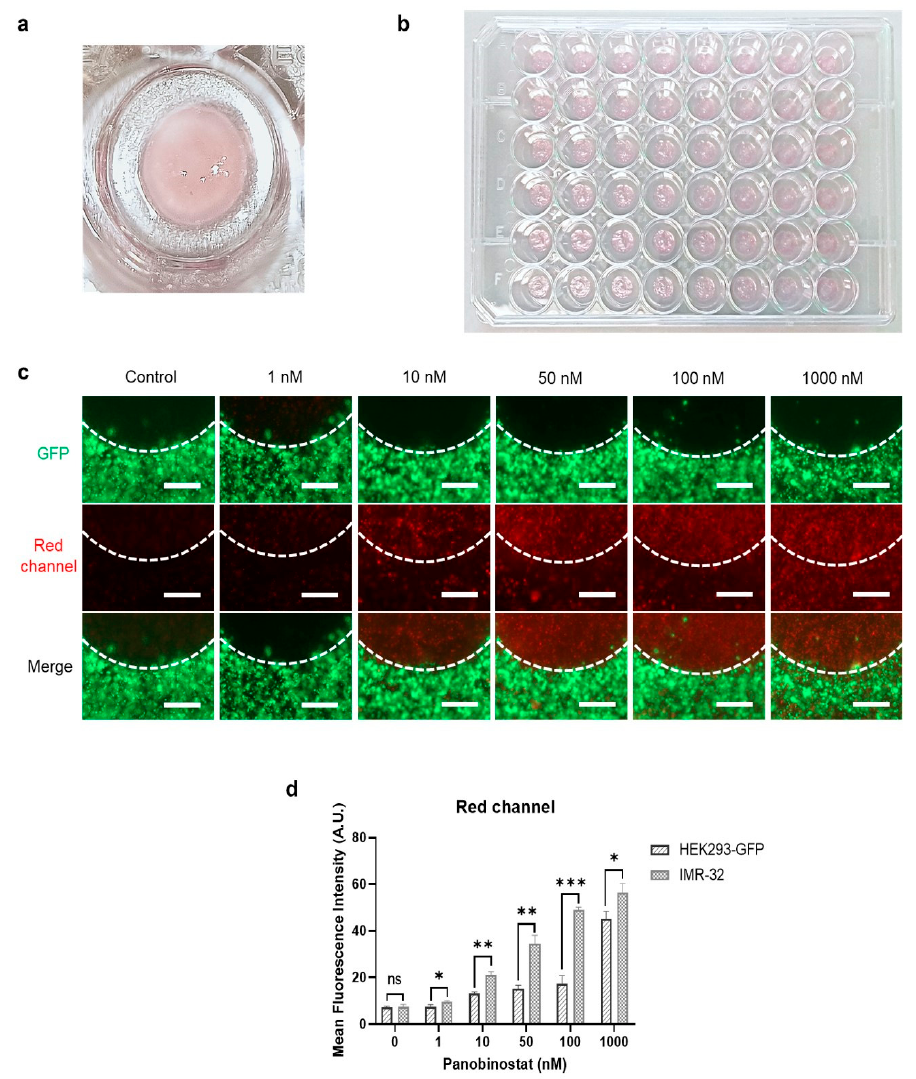
Figure 6. Cancer model and cytotoxicity assays following treatment with panobinostat. ( a ) The bioprinted cancer model consisted of a core of neuroblastoma IMR-32 cells (diameter of 3 mm, height of the construct 0.4 mm) surrounded by an environment of kidney cells (HEK293-GFP cells in these experiments, HEK293 cells and primary kidney fibroblasts, respectively, in experiments below, outer diameter is 6 mm). ( b ) Bioprinting can produce the constructs in a highly reproducible manner. ( c ) The cancer model was treated with panobinostat for 72 h and subsequently stained with ethidium homodimer-1. HEK293-GFP cells emitted green fluorescence, dead cells were identified by ethidium homodimer-1 staining in red. The boundary between both cell types is indicated by a dotted line. All images were taken at the same magnification; scale bar, 500 µ m. ( d ) Quantitative analysis of dead cells in HEK293-GFP and IMR-32 parts of the models by mean fluorescence intensity based on the red channel results. * p < 0.05, ** p < 0.01, *** p < 0.001. A completely different picture arose for blasticidin treatment. Here, no fluorescence originating from cleaved caspase-3 was observed at concentrations up to 10 µ M (Figure S4b). At higher concentrations, the signal became stronger in a dose-dependent manner in both parts of the model. Quantitative analysis of the fluorescence by ImageJ confirmed the blasticidin-sensitivity of both cell types is roughly equivalent (Figure S4d). The model thus allows distinguishing drugs which are specifically toxic to cancer cells like panobinostat from those that are generally cytotoxic such as